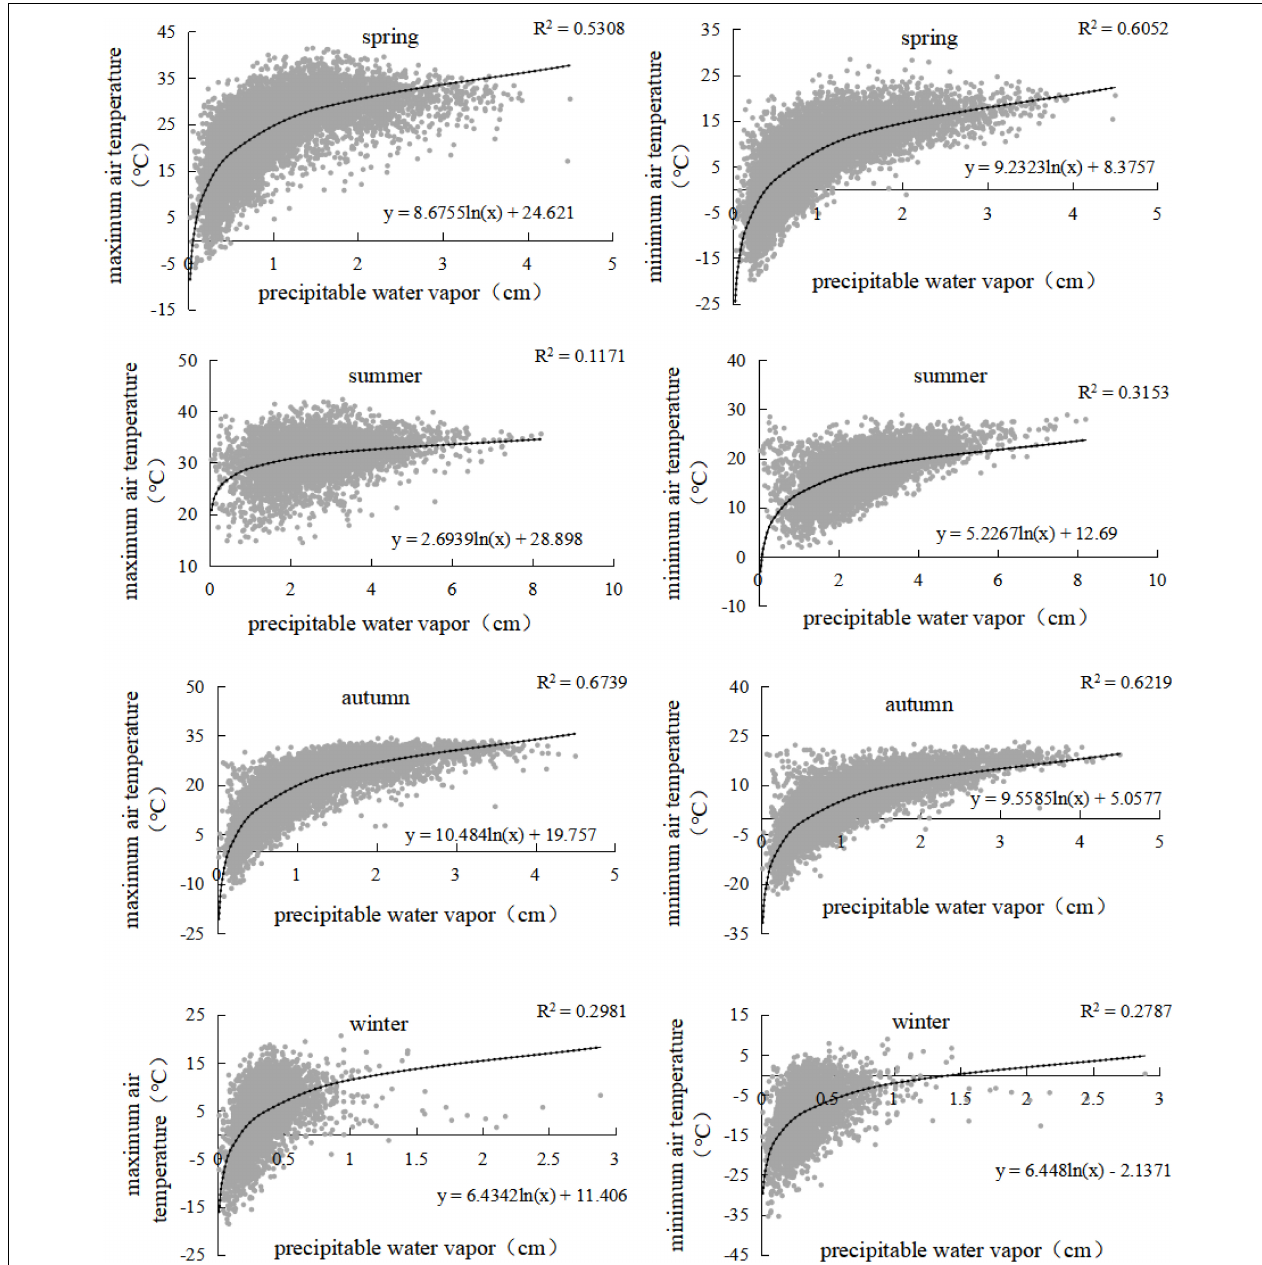
FIGURE 3 | Relationship between the temperature and atmospheric precipitable water by season in Haihe River Basin.